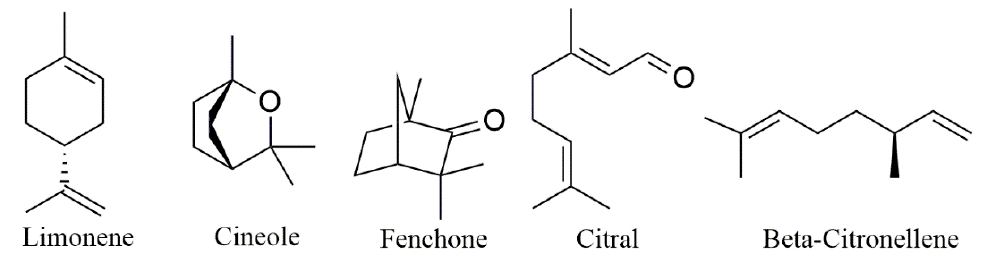
Figure 7. Monoterpenes used as permeation enhancers in nanostructured systems.